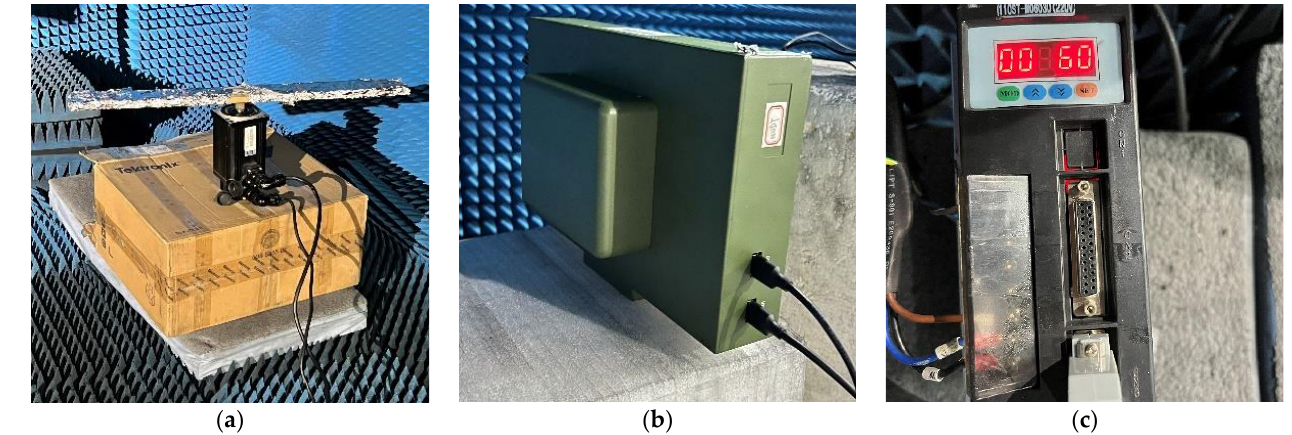
Figure 8. The micro-motion simulation device: ( a ) Two-bladed rotor target and motor. ( b ) FMCW radar. ( c ) Motor controller.